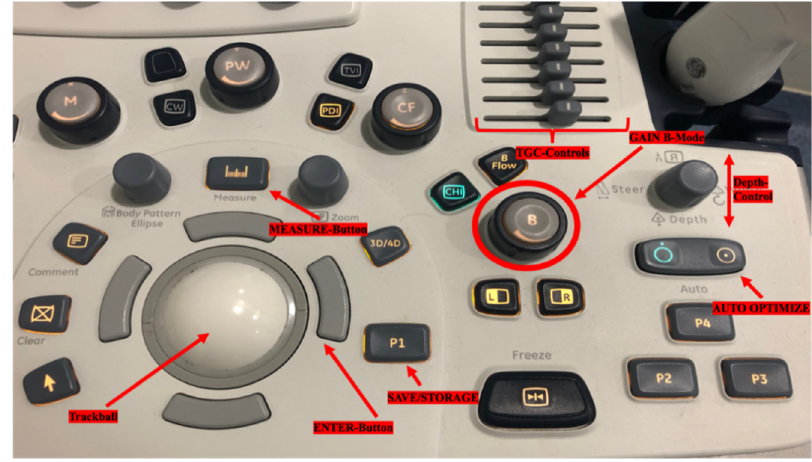
Figure 1. Knobology of a standard ultrasound (US) device. Useful buttons for simplified US usage are marked in red. Time gain controls (TCG) may be all set in the middle position. The depth is varied by the upper and lower lever actions (far right, up). The “Auto Optimize” button harmonizes the image quality. P1 can be programmed to save/store images (in freeze) or cine loops (in a nonfrozen visualization). Table 1. Functional classification of ultrasound (US) knobology. Group A comprises on-screen op- tions and knobs to store patient data, probe the selection, and classify the ultrasound findings for saved images. Group B includes knobs, switches, and buttons that help to adjust the Contrast, Fre- quency, Focus, Depth, and other settings. Group C summarizes the functions to quantify distances using a measuring tool.